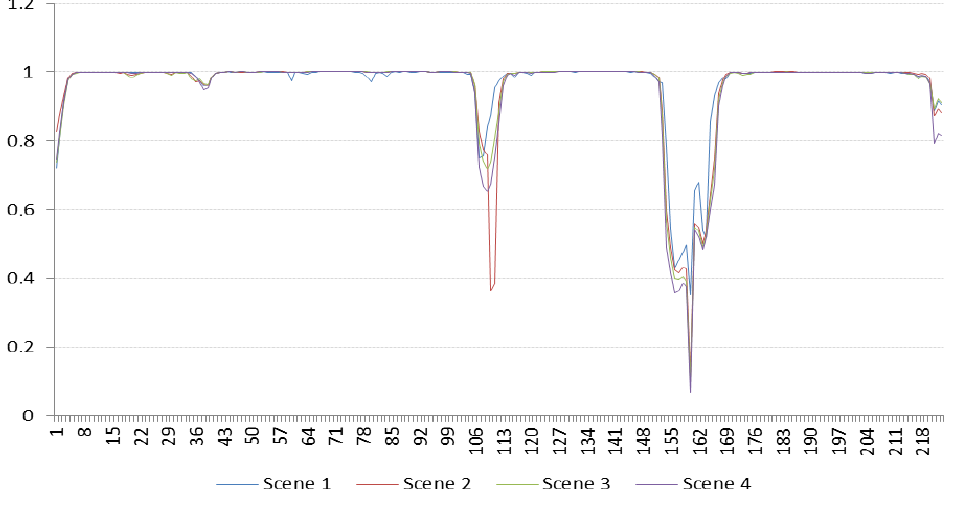
Figure 14. Correlation for continuous band for each scene of Moffett